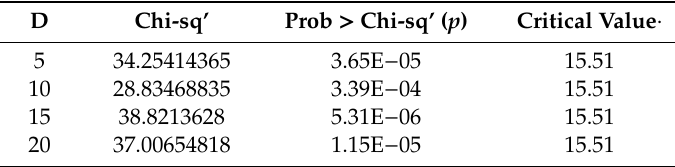
Table 39. Related statistical values obtained of Friedman test for α =